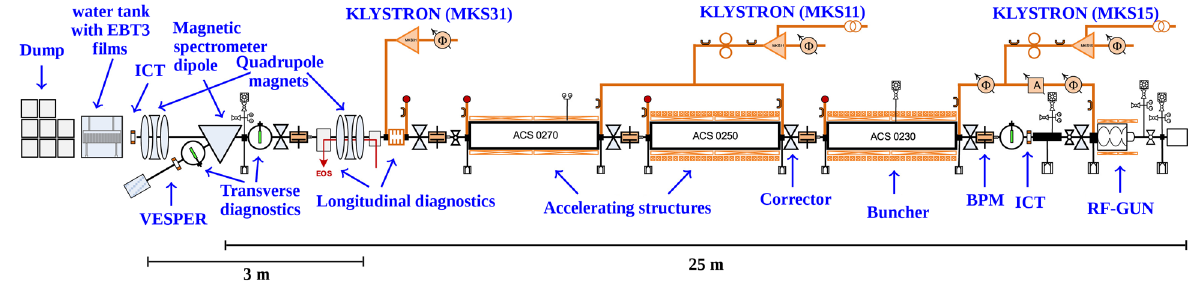
normalised to the peak dose of each individual depth – dose pro fi le.